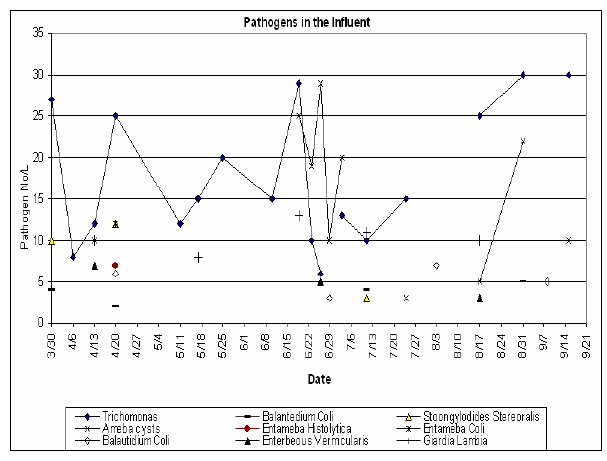
Figure 4: Pathogenic parasites and helminthes found in Albireh WWTP